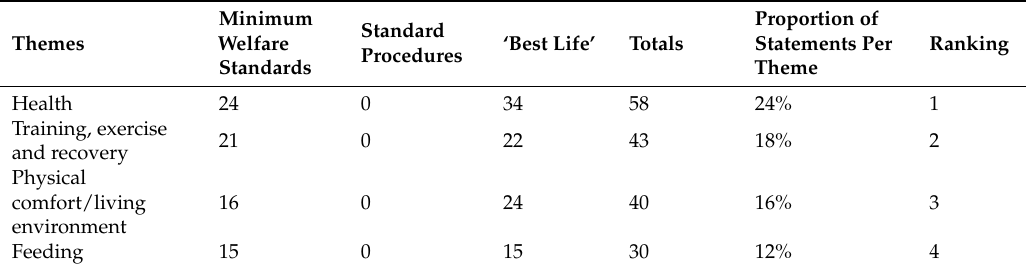
Table 2. Number of statements per theme and associated frequency